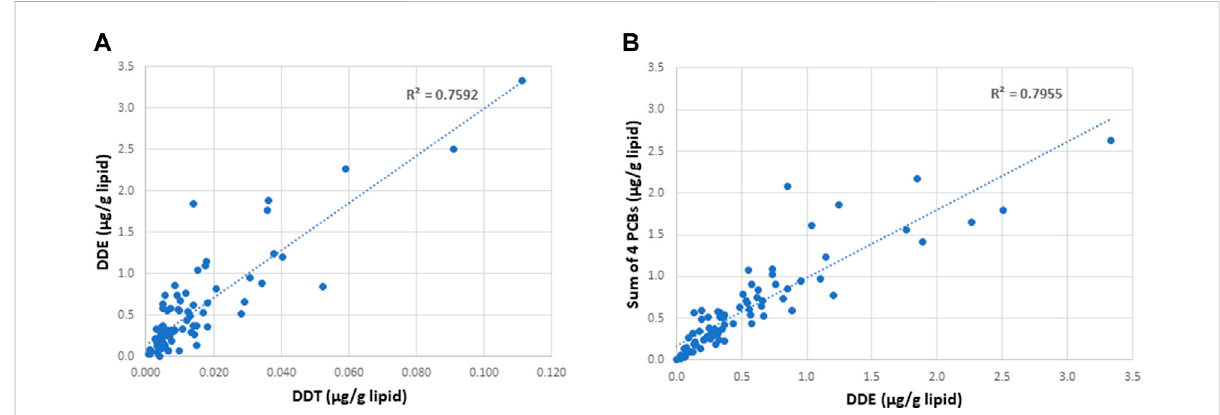
FIGURE 2 Correlation between the concentrations of DDE with those of DDT (A) and the sum of the four most prevalent PCB congeners (B) in the serum of semen donors. The 4 speci fi c PCB congeners are PCB 118, PCB 138, PCB 153, and PCB